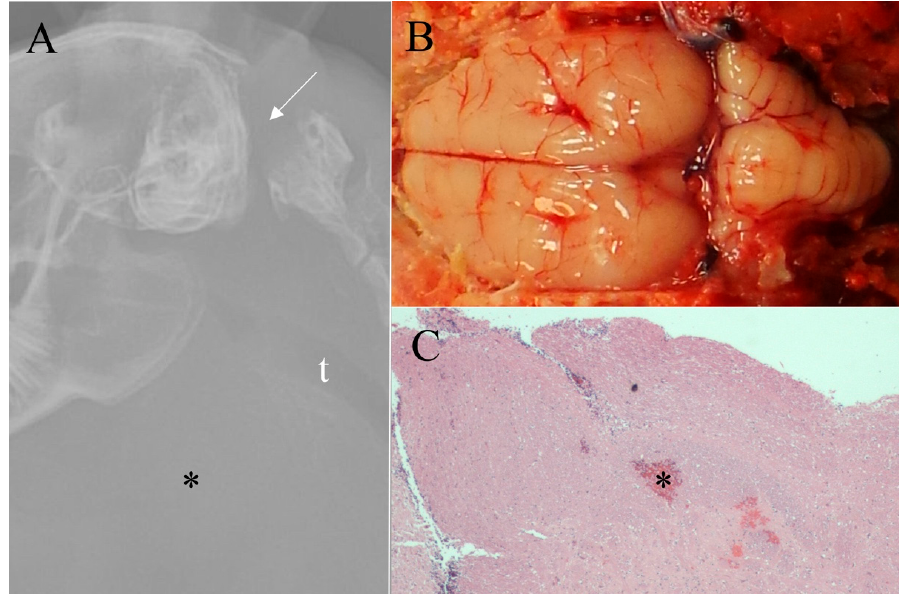
Figure 5. Eight week-old grower rabbit euthanized by mechanical cervical dislocation. ( A ) Survey radiograph shows a clean dislocation between the base of the skull and the first vertebrae (arrow) and marked cervical hemorrhage (*), t = trachea; ( B ) Grossly, no subdural dorsal hemorrhage was noted (gross score of 0/4); ( C ) Photomicrograph of midbrain demonstrating a lack of subdural hemorrhage (histologic score of 0/4) and minimal parenchymal hemorrhage (*) (histologic score of 1/4) (H & E, ×20).